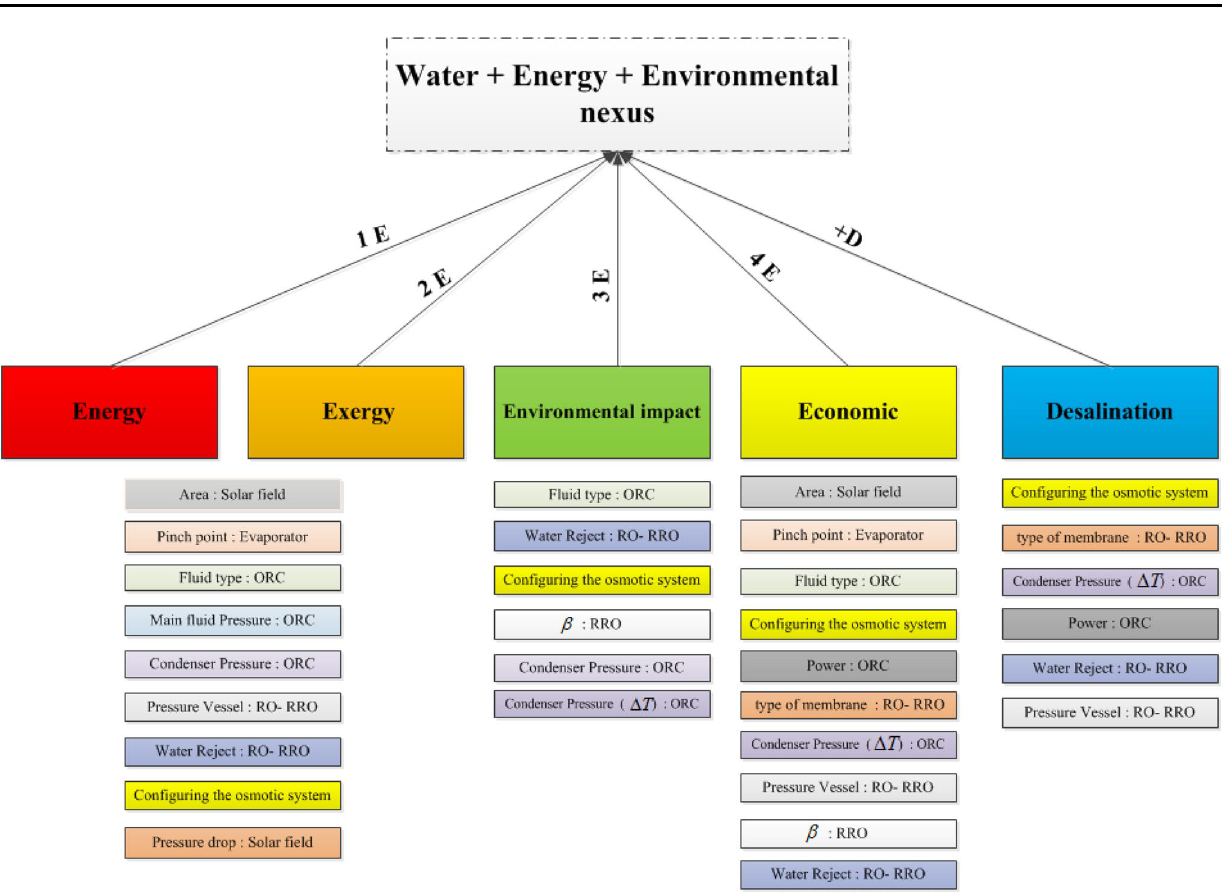
Fig. 2 Process block